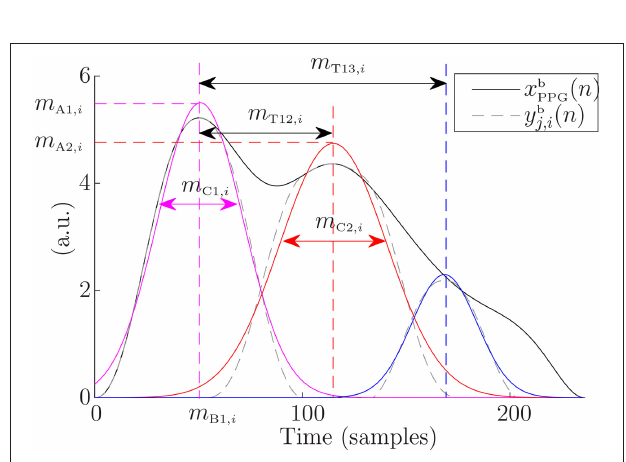
FIGURE 3 | Measures over the extracted waves of an example PPG pulse. Gaussians fitted to these waves are shown in